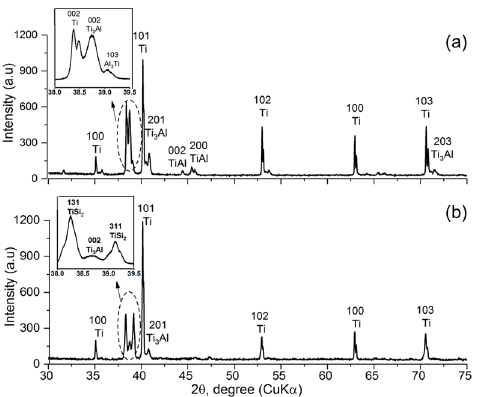
Figure 2. XRD patterns of Ti–Al samples before ( a ) and after Si + implantation ( b ) after annealing at 900 ° С .